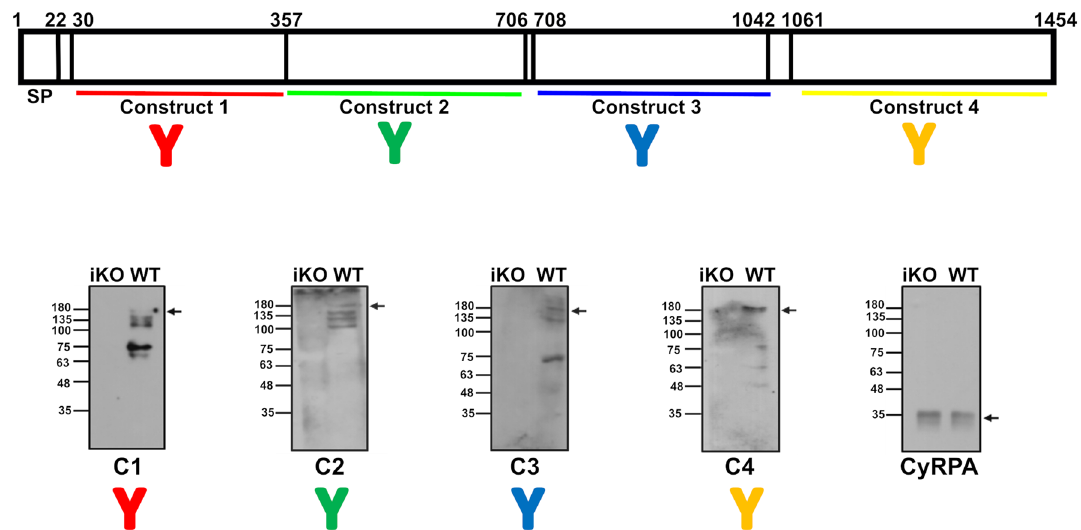
Figure 2. Immunoblotting with antibodies raised to PfMSA180-derived recombinant proteins detects the full-length PfMSA180 and displays processing of the protein in late schizont stages. Polyclonal antibodies raised in mice against the PfMSA180 recombinant proteins specifically detect the ~ 180 kDa protein in P. falciparum schizont lysates. WT- Wild type: schizont lysate prepared from control DMSO treated parasites, iKO- inducible knockout: schizont lysate prepared from rapamycin-treated parasites lacking MSA180 expression (see Fig. 5). Immunoblot analysis further detected additional polypeptides that may be fragments consistent with the protein undergoing proteolytic cleavage. Antibodies targeting N-terminal C1 recombinant protein identified the full- length protein (~ 180 kDa), and processed fragments of approximately 135 kDa, 100 kDa, 75 kDa and 63 kDa. C2-construct antibodies identified full-length protein (~ 180 kDa), and processed fragments of approximately 125 kDa and 96 kDa. C3-antibodies identified full-length protein (~ 180 kDa), and processed fragments of approximately 125 kDa and 75 kDa. C-terminal C4-antibodies identified full-length protein (~ 180 kDa), and processed fragments of approximately 75 kDa, 63 kDa and 48 kDa. Immunoblotting of the same parasite lysate preparation with anti-CyRPA antibodies on the same membrane was performed as loading control for late schizont stages. Full length immunoblots are shown in Supplementary Fig.